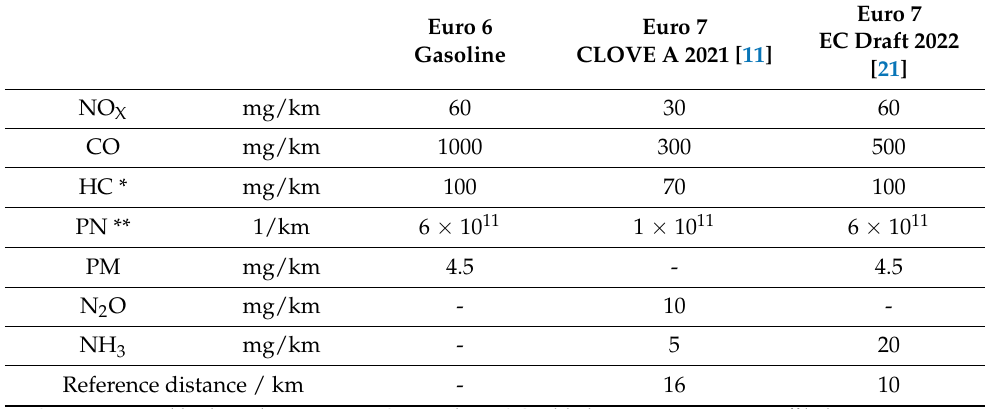
Table 1. Proposal for Euro 7 emission limits for vehicle class M1 in mg/km [11,40].